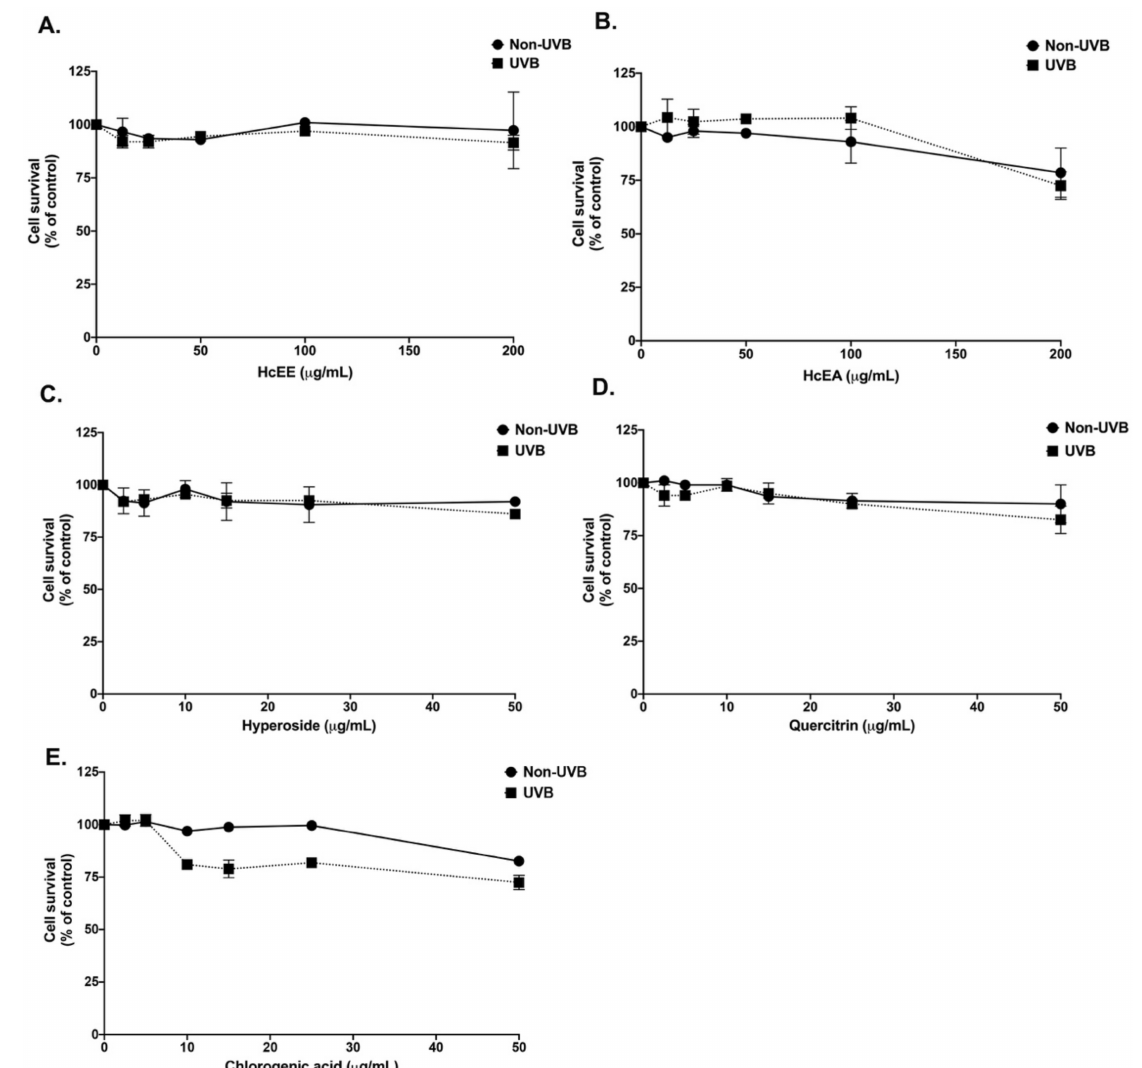
Figure 2. Effects of H. cordata extracts and main active compounds on human dermal fibroblast cell viability. Cells were exposed with or without UVB at the intensity of 15 mJ/cm 2 then treated with HcEE ( A ), HcEA ( B ), hyperoside ( C ), quercitrin ( D ) and chlorogenic acid ( E ) for 48 h. Cell survival was determined using SRB assay. Data are presented as mean ± S.D. values of three independent experiments. HcEE: H. cordata ethanolic extract, HcEA: H. cordata ethyl acetate fraction, UVB: cells exposed with 15 mJ/cm 2 of UVB, Non-UVB: control group of cells non-exposed to